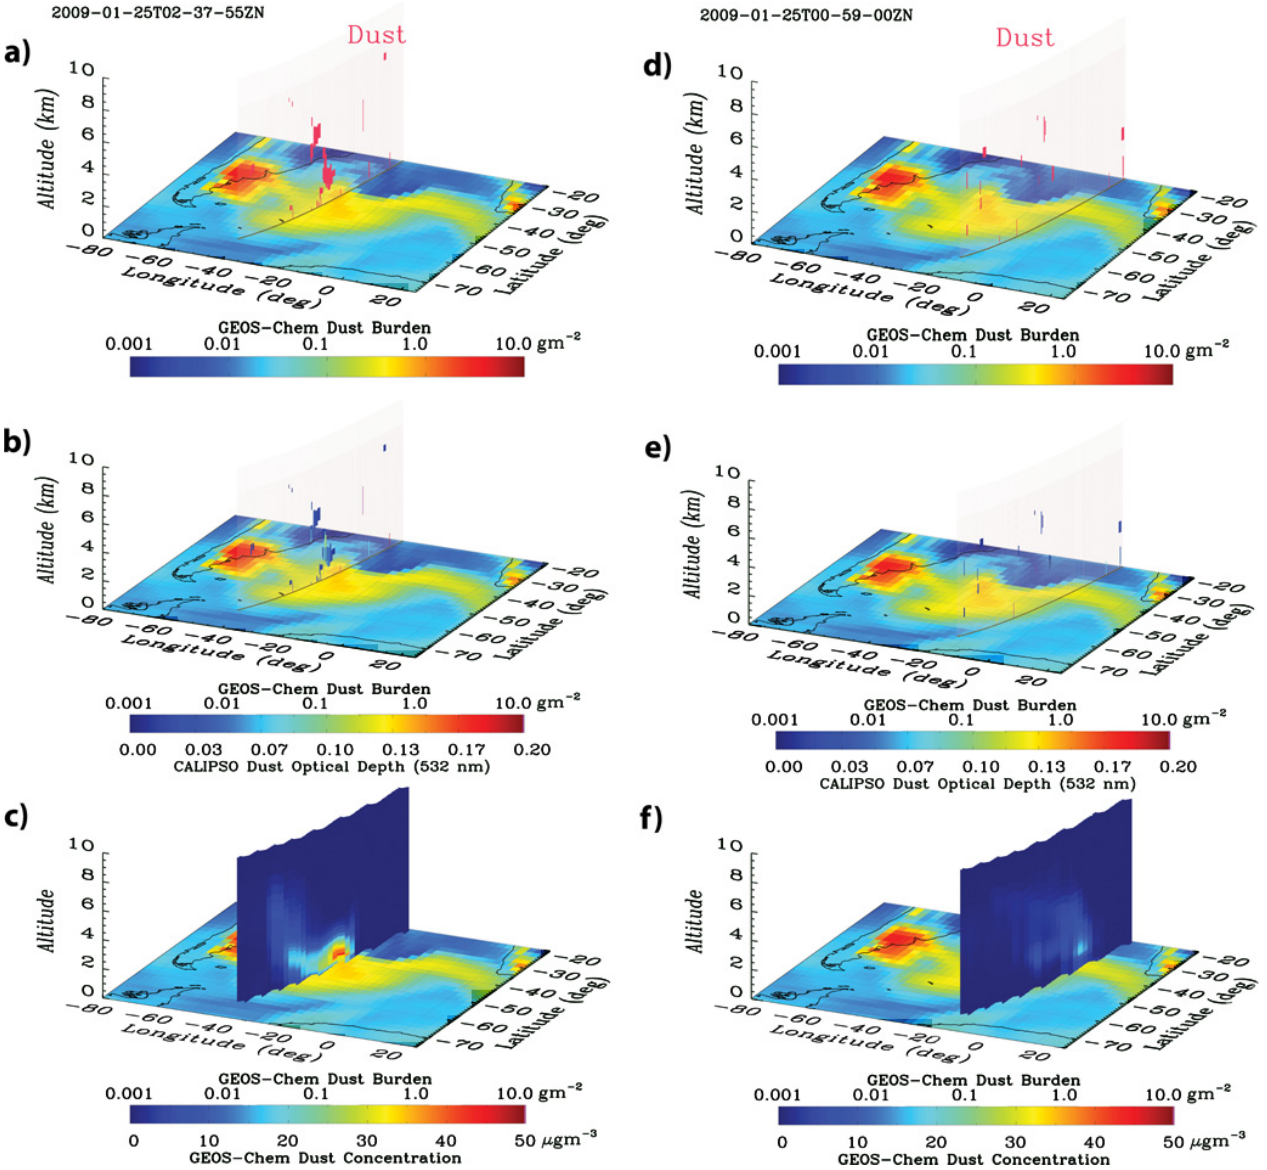
Fig. 5. The background images are the GEOS-Chem-predicted dust burden (gm − 2 ) on 25 January 2009 overlaid with vertical swaths of the CALIPSO orbital track beginning at 02:37:55 UTC (V3-01.2009-01-25T02-37-55ZN) (left column) and 00:59:00 UTC (V3-01.2009- 01-25T00-59-00ZN) (right column) displaying the (a) , (d) CALIPSO retrievals of dust aerosol layers, (b) , (e) CALIPSO dust layer AOD at 532nm, and (c) , (f) model-predicted vertical cross-section of dust concentration (µgm − 3 ) along the CALIPSO orbit